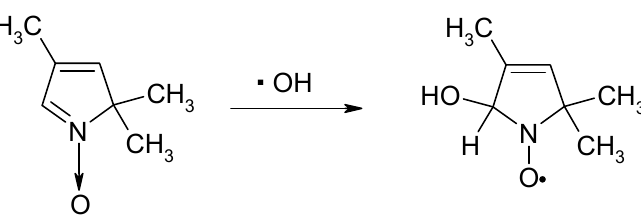
Figure 3. Fragments of the 1 H NMR spectra of 0.4 mM of ascorbic acid in D 2 O at pH = 4.1 in the absence and in the presence of 0.1 mM of FeL1 3 complex just after mixing and after one-hour storage at room temperature.